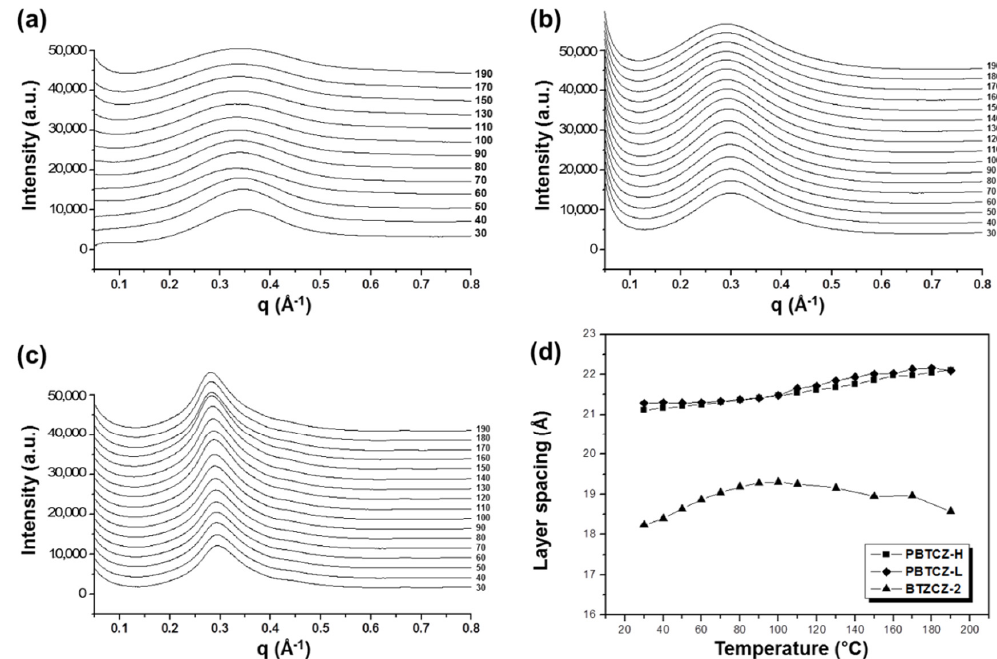
Figure 3. X-ray scattering profiles for ( a ) BTZCZ-2 , ( b ) PBTZCZ-L , and ( c ) PBTZCZ-H at 30 – 190 °C, and ( d ) dependence of layer spacing of the samples on increased temperature.